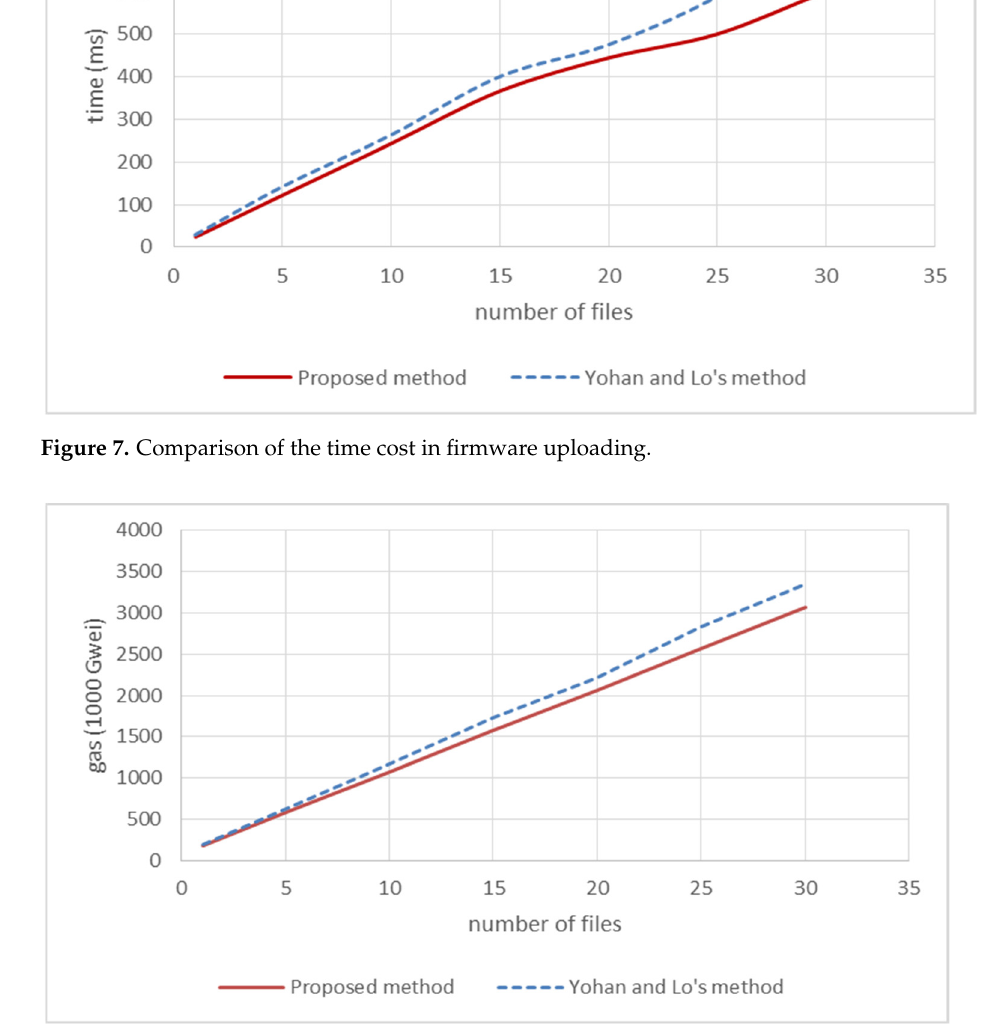
Figure 8. Comparison of the gas cost in firmware uploading.